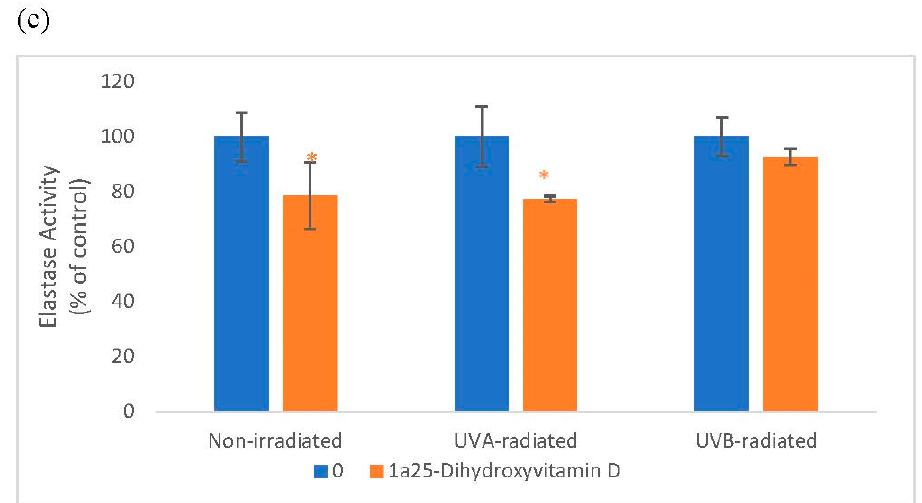
Figure 3. The effect of 1 α , 25 dihydroxyvitaminD3 (vitamin D) on Elastin Promoter Activity, Elastin Protein Levels, and Elastase Activity in non-irradiated, UVA-radiated, and UVB-radiated fibroblasts. Fibroblasts were co-transfected with elastin promoter- firefly luciferase (pGL4 vector) and TK-hRenilla luciferase plasmids (for normalization) for 24 h, non-irradiated (blue), UVA-radiated (orange), or UVB-radiated (grey), incubated with vitamin D (0–2 µM) for 24 h, and assayed for luciferase activities ( a ); and for elastin protein levels by indirect ELISA (Kirkguaard and Perry Inc) ( b ). Non-irradiated, UVA-radiated, or UVB-radiated fibroblasts were incubated with vitamin D (0 or 0.2 µM) and examined for cellular elastase activity ( c ). * = p < 0.05, relative to respective controls. Error bars represent standard deviation, n = 4.